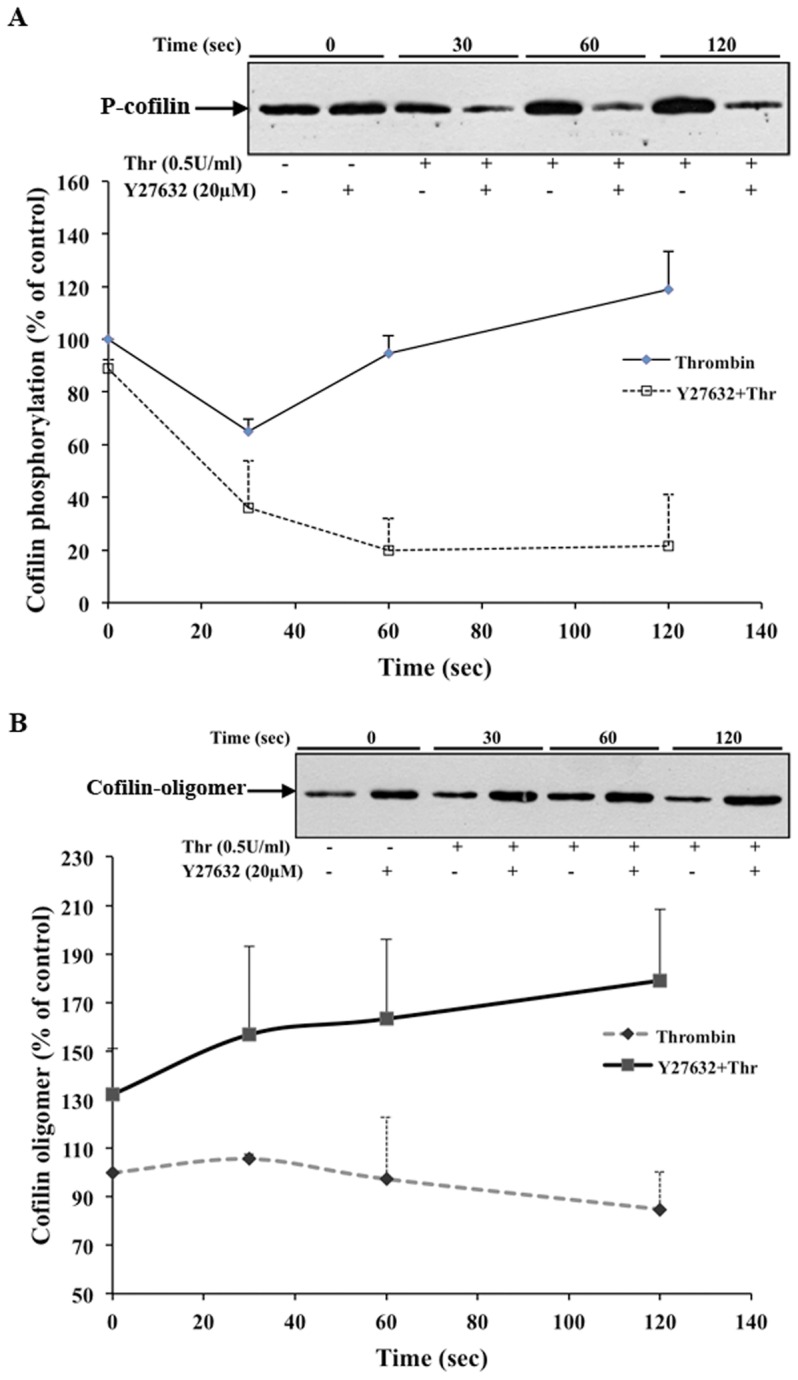
Cofilin dephosphorylation stimulates cofilin oligomer formation in platelets.Effects of Y27632-treatment and thrombin stimulation. Human washed platelets were incubated with Y27632 (20 µM) or solvent (water) for 20 minutes and then stimulated by thrombin (0.5 U/ml). Platelets were lysed in Laemmli buffer for immunoblot analysis with anti-phospho-cofilin antibody or with lysis buffer containing BMOE (0.1 mM) for immunoblot analysis of cofilin oligomer with anti-cofilin antibody. A) Graphic representation of changes of cofilin phosphorylation in thrombin-stimulated platelets in the presence or absence of Y27632. Values are the mean ± SD for four independent experiments. Insert: representative anti-phospho cofilin immunoblot. B) Graphic representation of changes of cofilin oligomer (65 kDa) formation in thrombin-stimulated platelets in the presence or absence of Y27632. Values are the mean ± SD for four independent experiments. Insert: representative immunoblot of cofilin oligomer (65 kDa) formation.